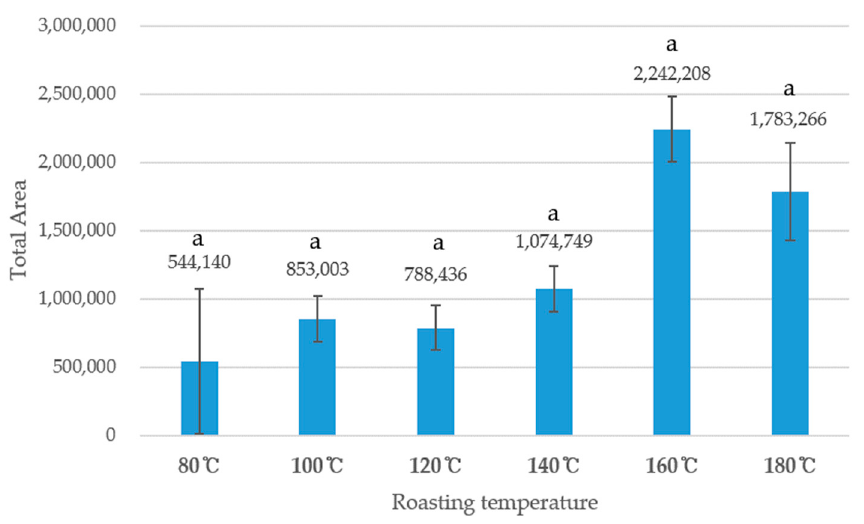
Figure 1. Total Peak Area of shiitake mushroom roasted in six different temperatures. 80 ◦ C represents shiitake mushroom roasted at 80 ◦ C; 100 ◦ C represents shiitake mushroom roasted at 100 ◦ C; 120 ◦ C represents shiitake mushroom roasted at 120 ◦ C; 140 ◦ C represents shiitake mushroom roasted at 140 ◦ C; 160 ◦ C represents shiitake mushroom roasted at 160 ◦ C. Alphabetical letter “a” followed by numbers represent no significant differences in peak area ration between shiitake mushroom samples roasted in different temperatures. Table 4. Volatile flavor analysis results of shitake mushroom roasted in different temperatures. Peak # R.